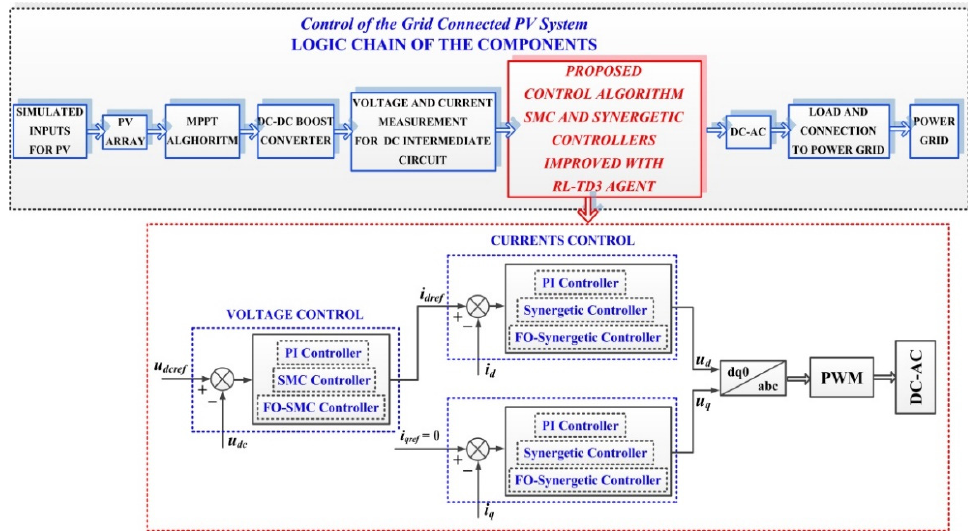
Figure 2. The schematic diagram of the cascade control system for the GC-PV system.